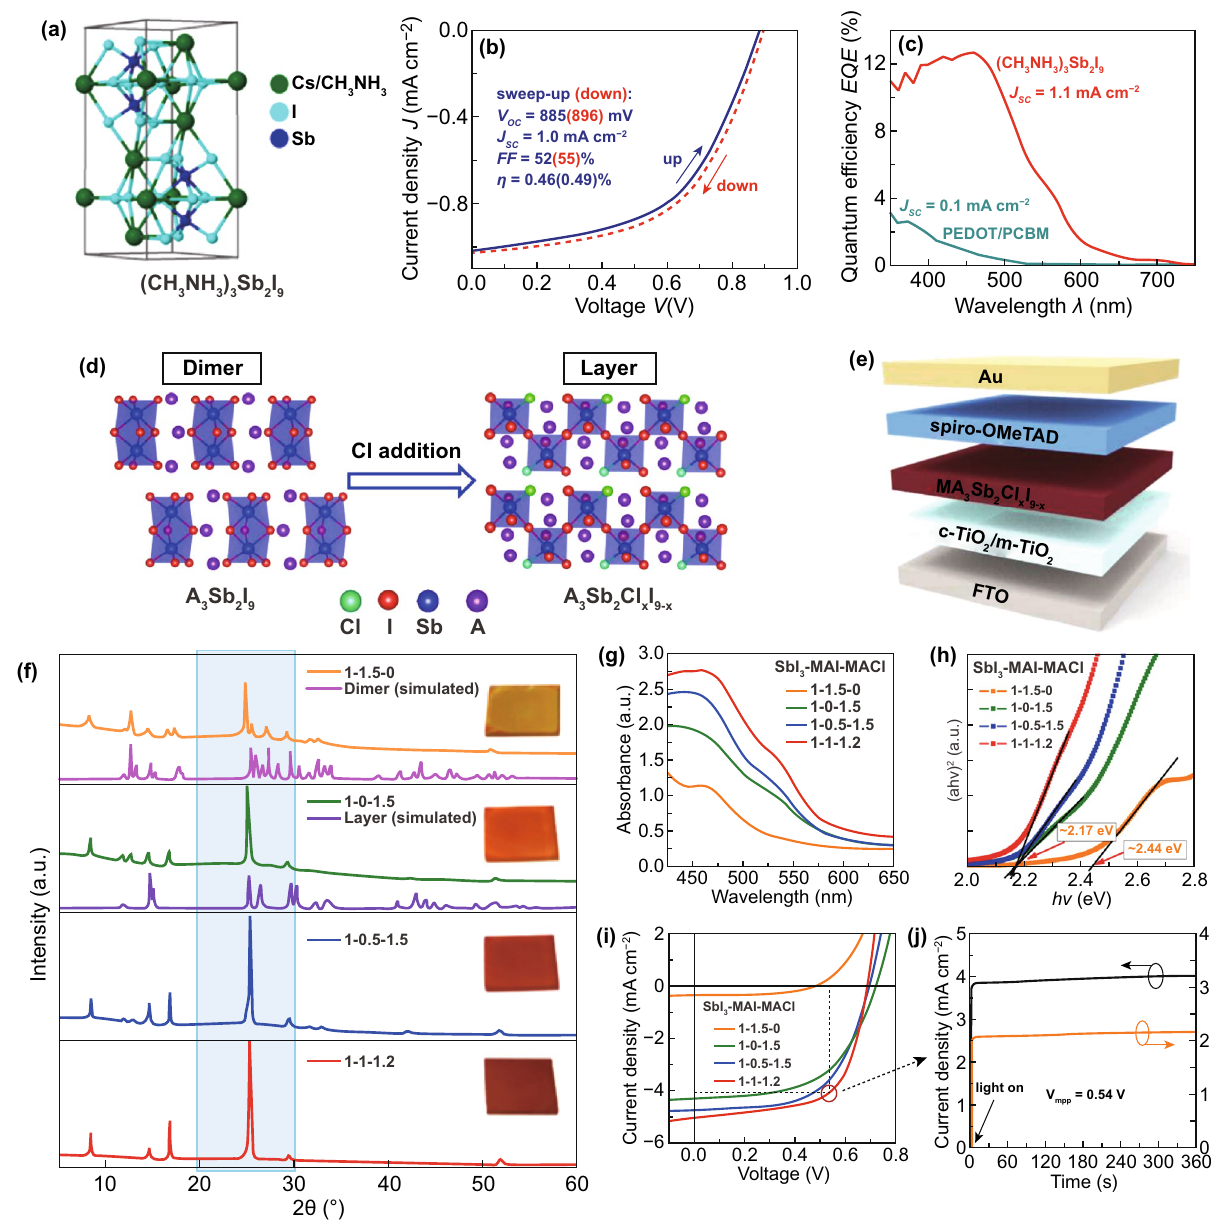
Fig. 14 a Crystal structure of (CH 3 NH 3 ) 3 Sb 2 I 9 (space group P6 3 / mmc ). b Illuminated J – V curves of (CH 3 NH 3 ) 3 Sb 2 I 9 solar cell measured with forward and backward scanning with a rate of 0.1 V s −1 . c EQE measurement of the (CH 3 NH 3 ) 3 Sb 2 I 9 solar cell compared to the reference device of ITO/PEDOT/PCBM/ZnO-NP/Al. Reproduced with permission from Ref. [173] d Schematic plot of the Cl doping-induced transformation from the 0D dimer phase of A 3 Sb 2 I 9 to the 2D layered phase of A 3 Sb 2 Cl X I 9−X . e Schematic structure of the as-fabricated PSC. f XRD patterns of the films deposited from precursors containing SbI 3 , MAI, and MACl with molar ratios of 1:1.5:0, 1:0:1.5, 1:0.5:1.5, and 1:1:1.2. g Measured UV–vis absorbance spectra of the four types of films. h Tauc plots of the absorption coefficients for evaluating the bandgap values of the pure- iodine perovskites MA 3 Sb 2 I 9 and Cl-containing mixed-halide perovskites MA 3 Sb 2 Cl X I 9−X . i J – V curves for the devices fabricated with the four kinds of perovskite films. j Steady-state photocurrent output for the device based on 1-1-1.2 film at the maximum power point (red circle). Maxi- mum power point voltage V mpp is equal to 0.54 V. Reproduced with permission from Ref.